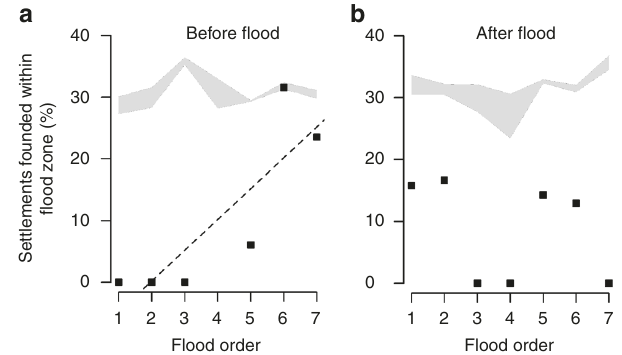
Fig. 3 Living in the fl ood zones. A comparison between the proportions (frequencies, %) of new settlements actually established inside fl ood zones before and after seven historical extreme fl ood disasters (black squares) and a range of virtual fl ood events based on randomized simulations (grey area). The dashed line indicates a statistically signi fi cant trend (see Results). No data were available before the 4 th fl ood event